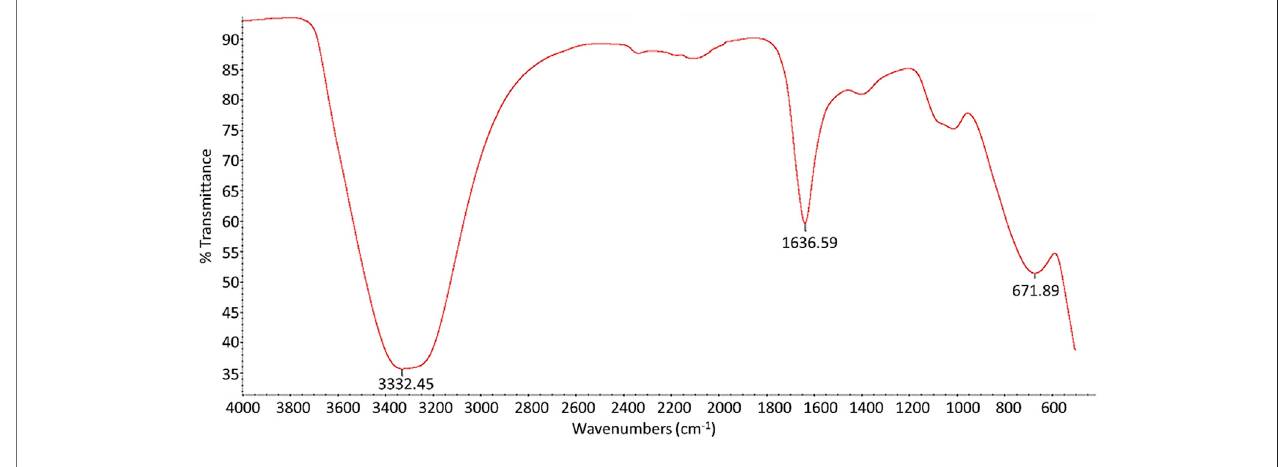
FIGURE 3 | FTIR spectrum of ZnO